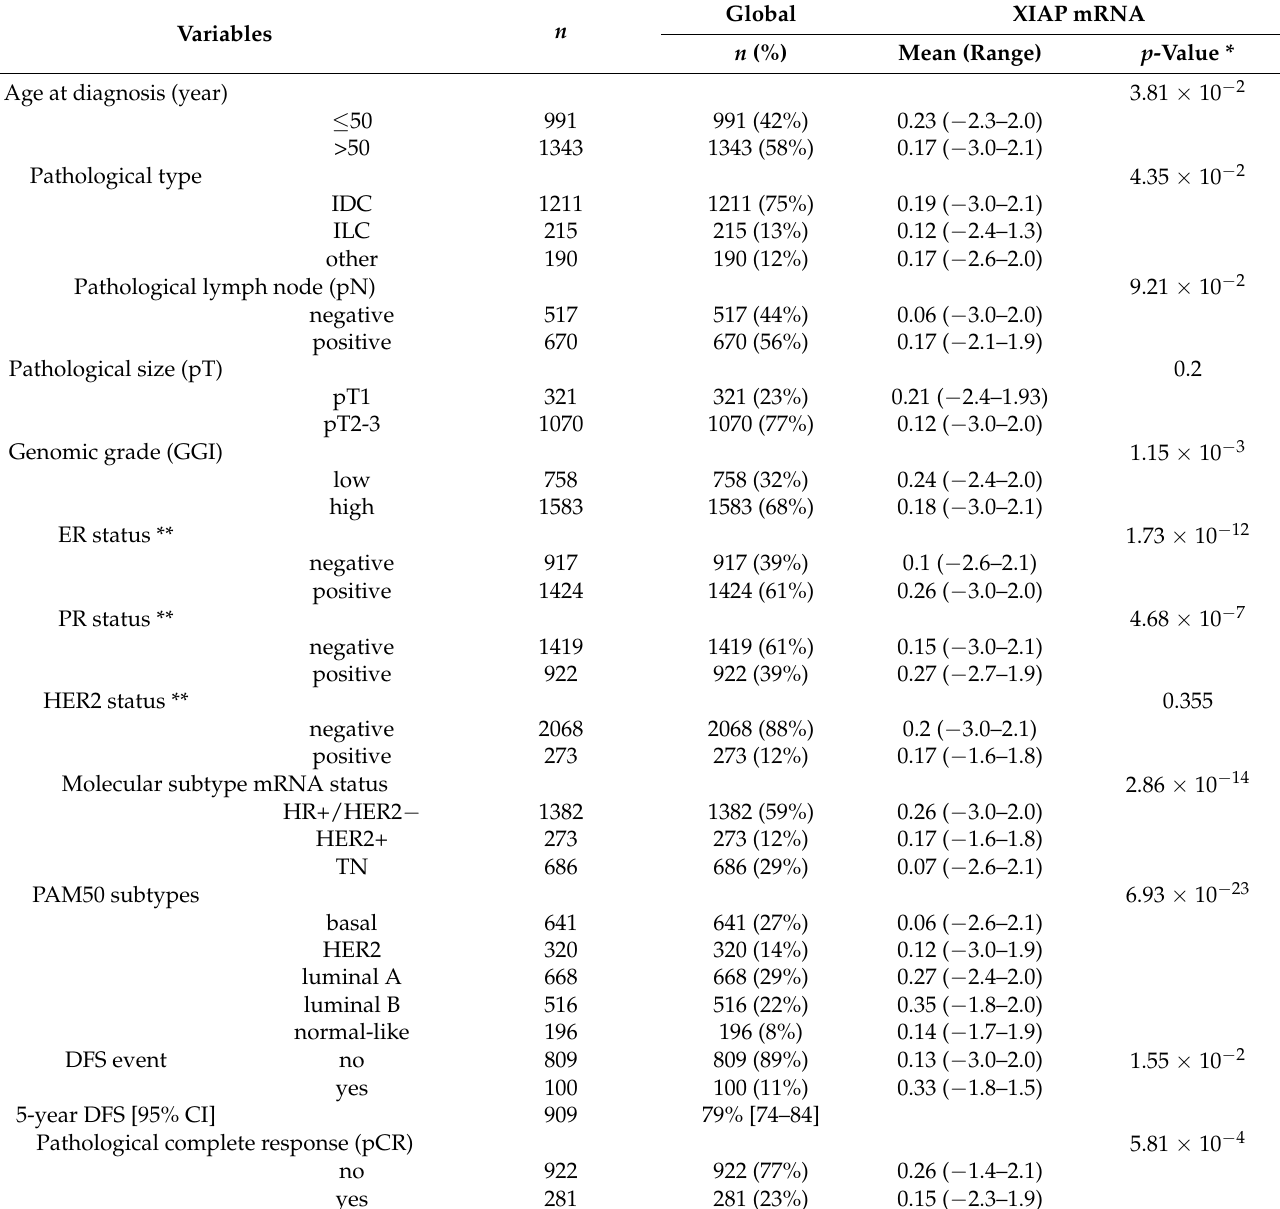
Table 1. XIAP mRNA expression and clinicopathological